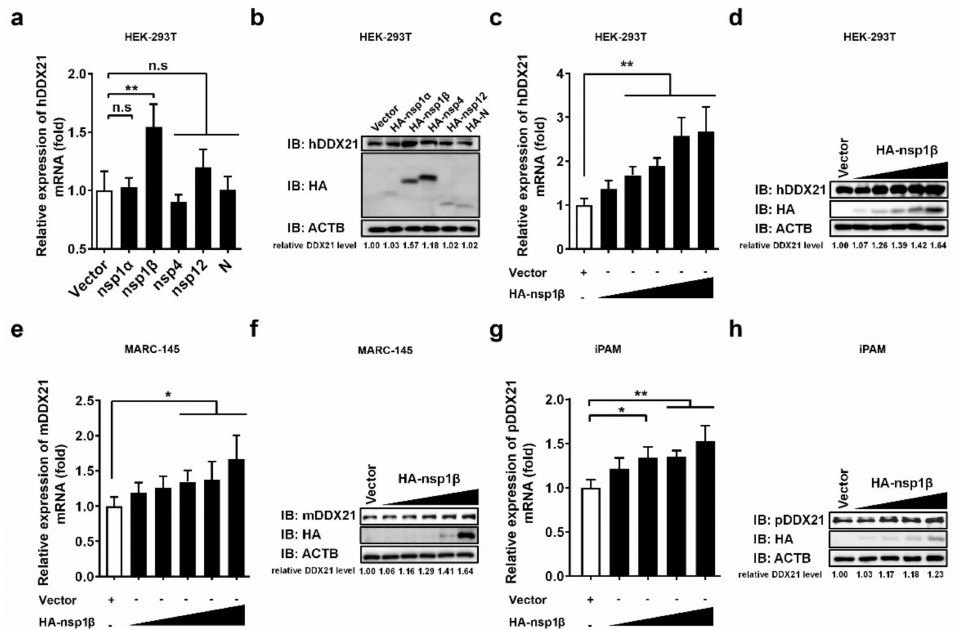
Figure 5. PRRSV nsp1 β upregulates DDX21 transcription and expression. ( a , b ) HEK-293T cells